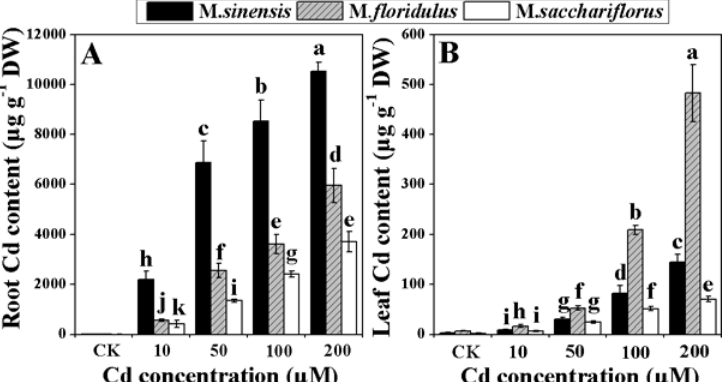
Fig 2. Change in root Cd content (A) and leaf Cd content (B). Data are mean ± SD (n = 3). Different letters indicate a significant difference at P <